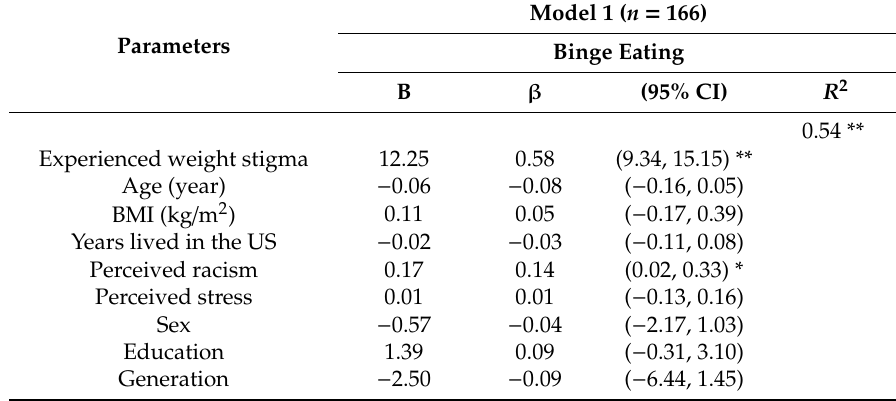
Table 4. Results from the multiple linear regression for the association of experienced weight stigma with binge